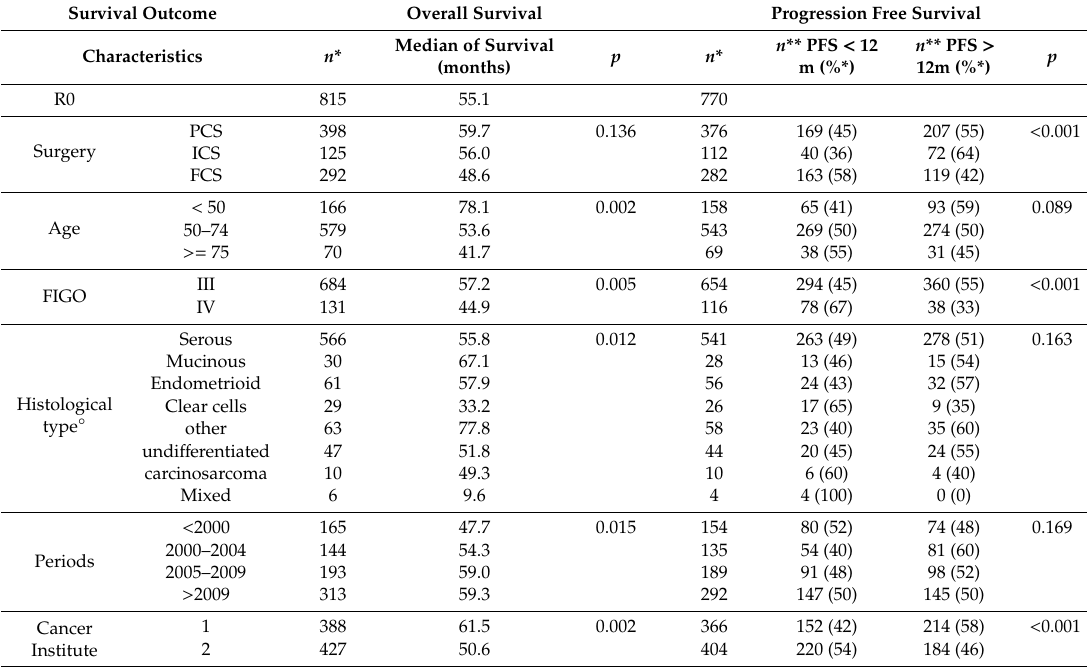
Table 2. Overall survival and Progression Free survival for patients with Complete Cytoreduction